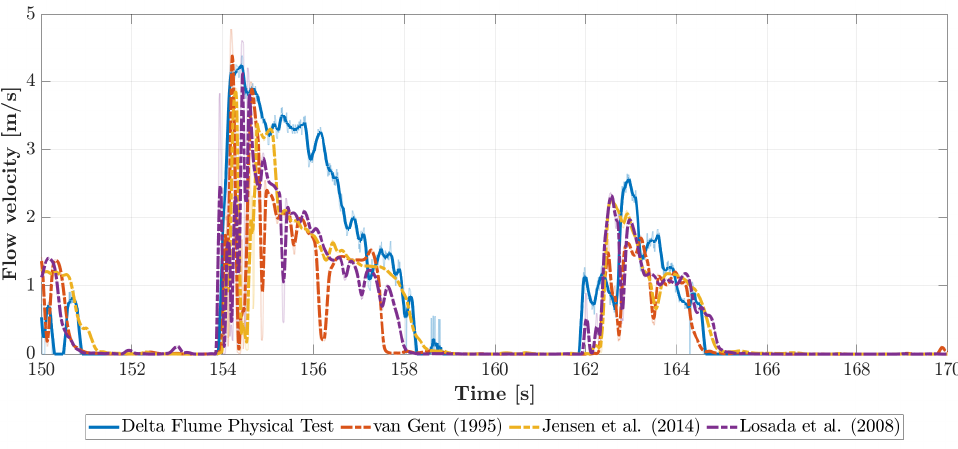
Figure 8. The measured flow velocity at PW1 between t = 150–170s in Test B together with the mod- elled flow velocity using resistance coefficients of Van Gent [26], Jensen et al. [18], Losada et al.